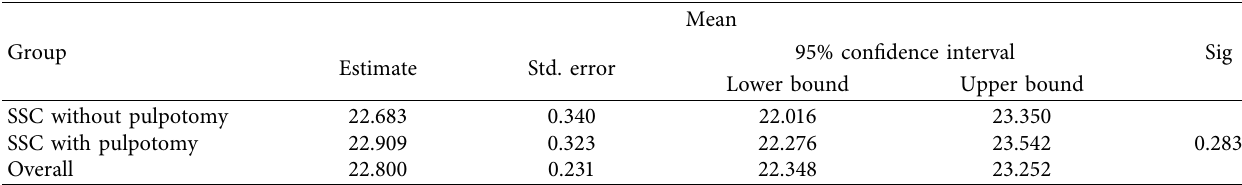
Table 1: Survival analysis for stainless-steel crowns with and without pulpotomy. Group